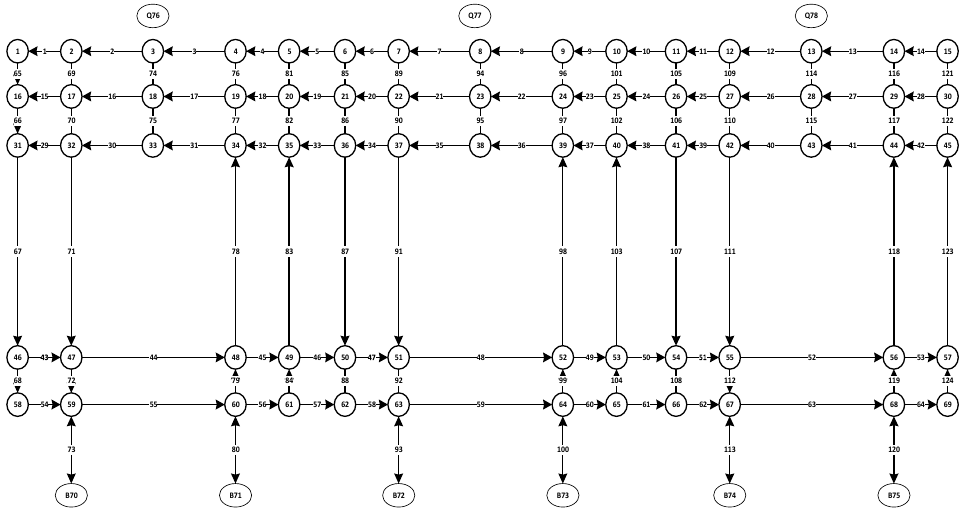
Figure 2. The AGV transportation area network.